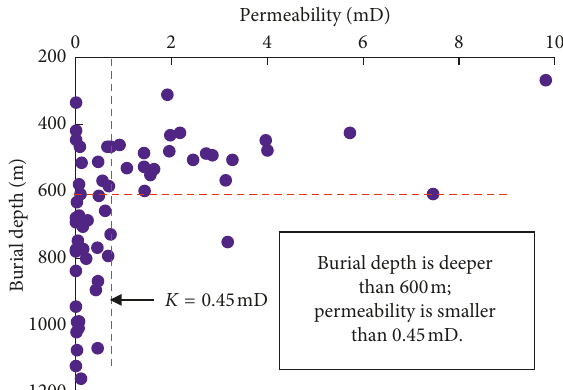
Figure 2: Relational graph of permeability and burial depth.